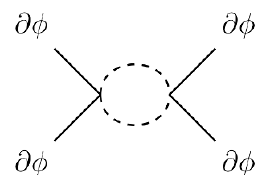
Figure 1 . One-loop diagram contributing to the 2-to-2 scattering amplitude with only scalar prop- agators. The legs with more than one derivative are taken to be on the internal lines, represented by a dashed